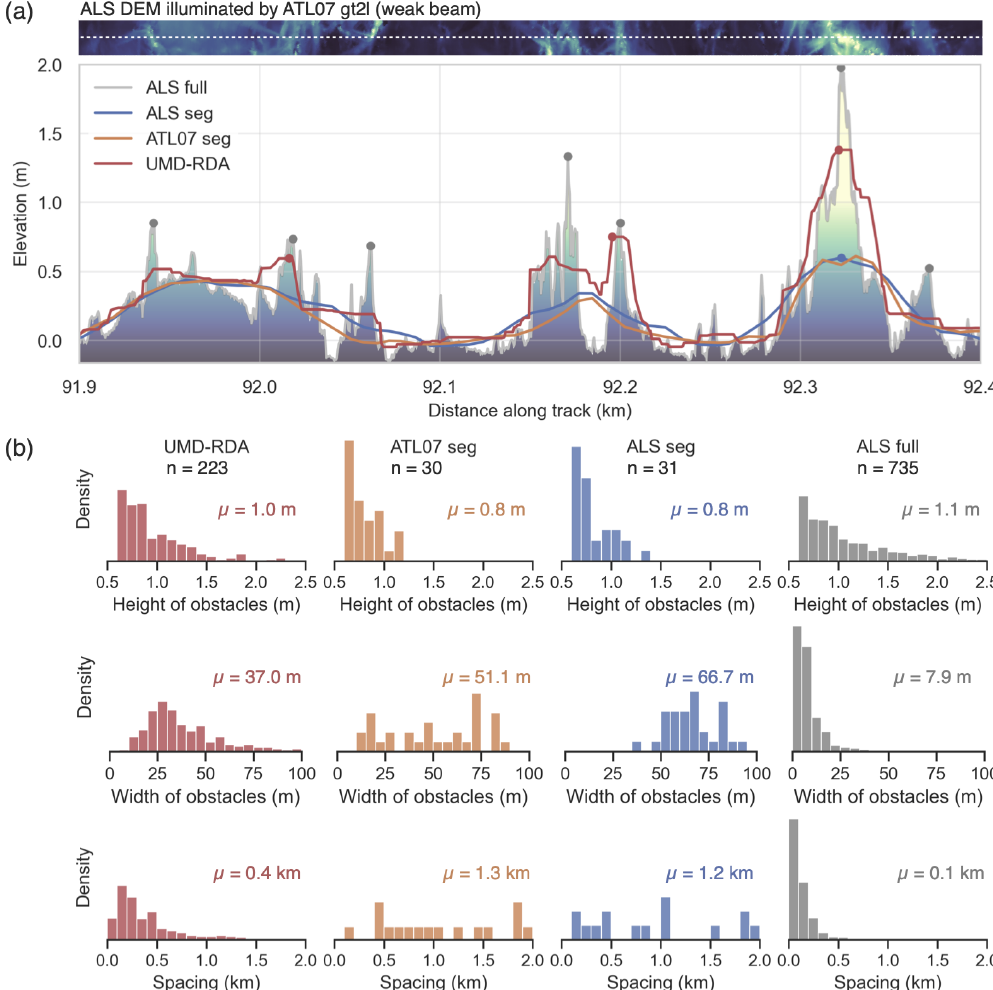
Figure 10. The same as Fig. 9 but for the weak beam